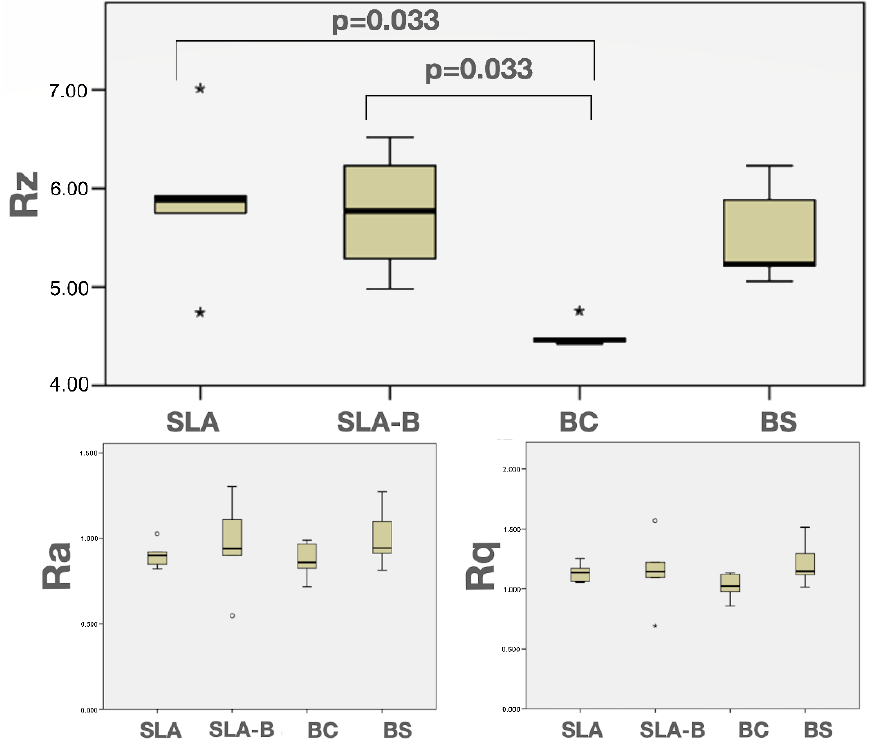
Figure 4. Three- and two-dimensional images of the experimental surfaces revealed using the atomic force microscope (AFM).